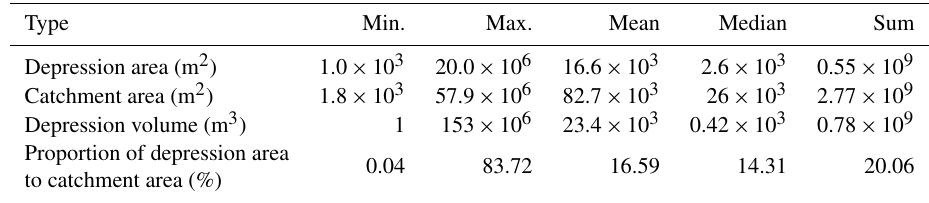
Table 3. Summary statistics of 33241 wetland depressions and catchments derived from lidar DEM.